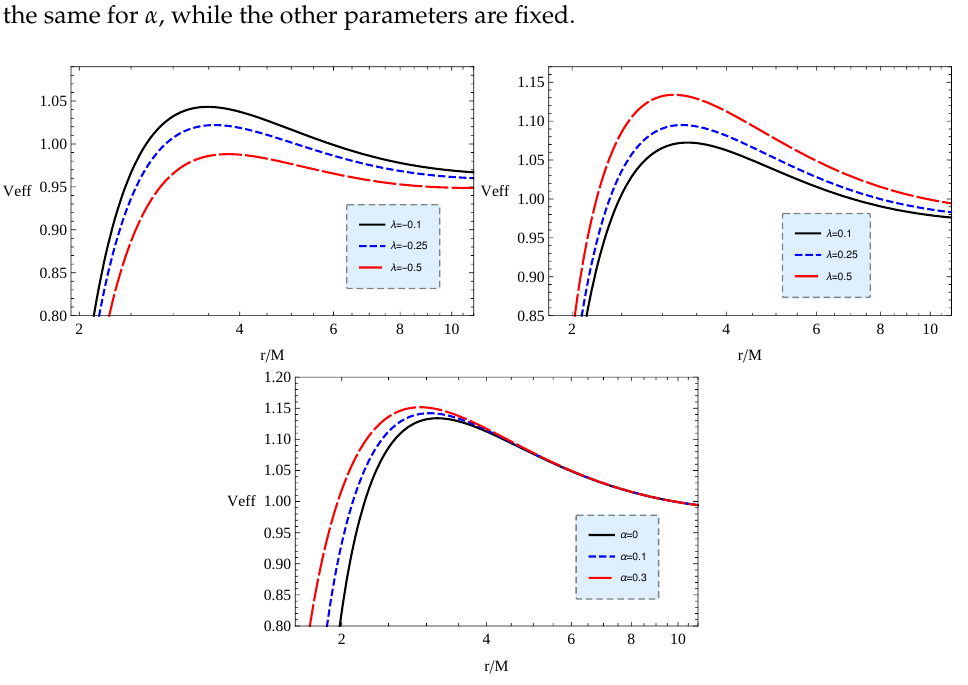
Figure 8. Effective potential dependence on radial distance for magnetically charged test particles, moving around the Bardeen regular black hole in 4D EGB gravity, possessing magnetic charge g . Top panels: V eff against r / M for different values of negative and positive magnetic charge parameter λ in the case of fixed g = 0.5 and α = 0.5. Bottom panel: For different values of the parameter α in the case of fixed g = 0.5 and λ =